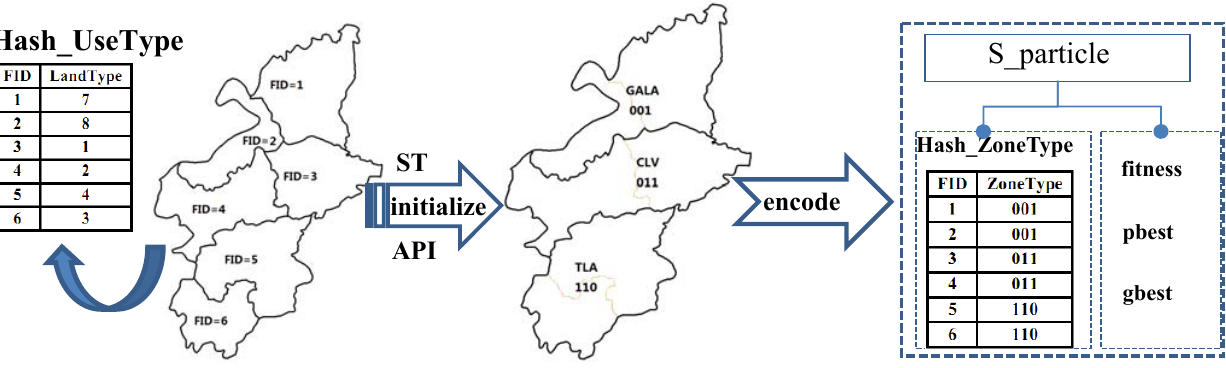
Figure 5. The coding scheme for a particle.